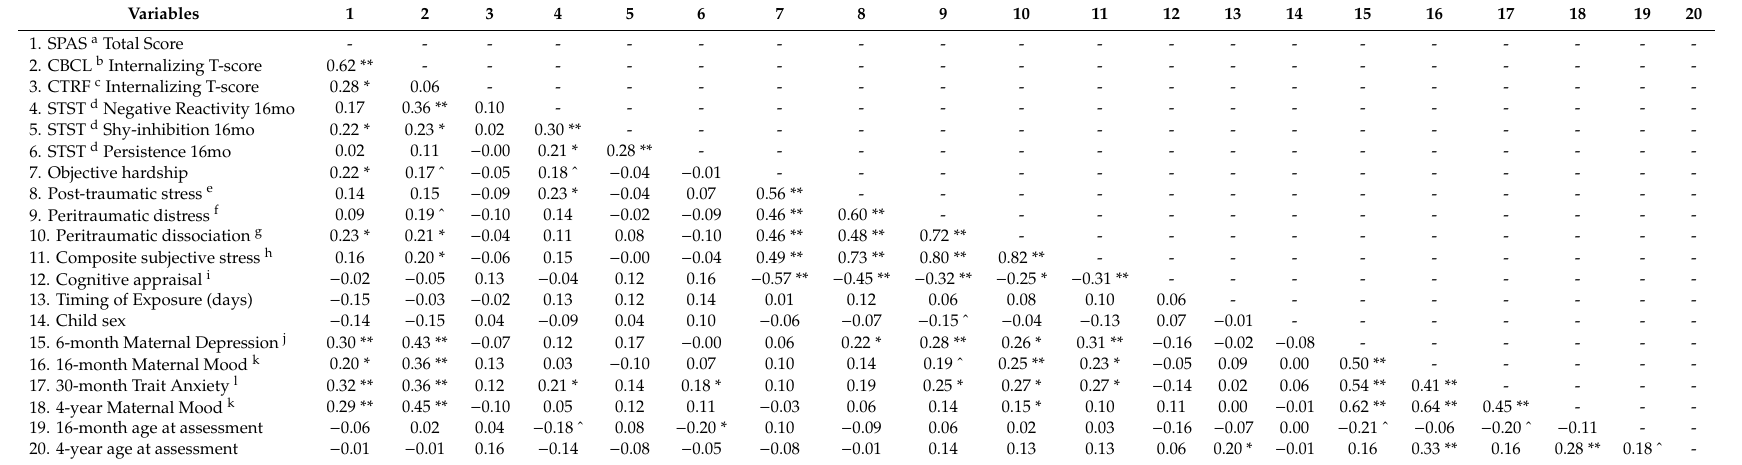
Table 2. Pearson’s correlations between study variables for the maternal-report sample ( N =